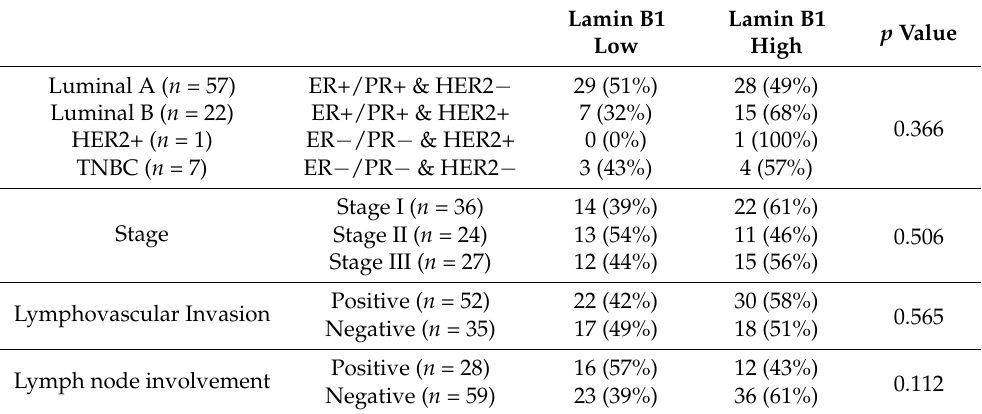
Table 2. Association of lamin B1 expression and clinicopathological variables of invasive breast carcinoma samples (Group B, n = 87). The table depicts statistical analysis of the association between lamin B1 expression in malignant breast cancer tissue and patients’ clinicopathological characteristics. Group B breast cancer samples were not exposed to neoadjuvant chemotherapy. p values were calculated using Pearson’s chi-square or Fisher’s exact non-parametric